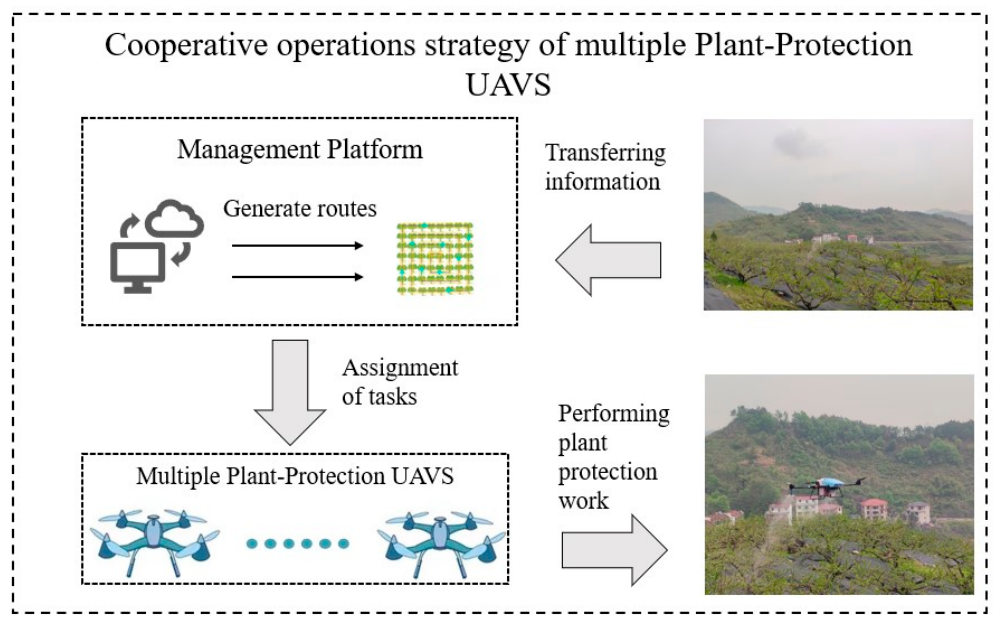
Figure 7. Cooperative operations strategy of multiple plant-protection UAVs.